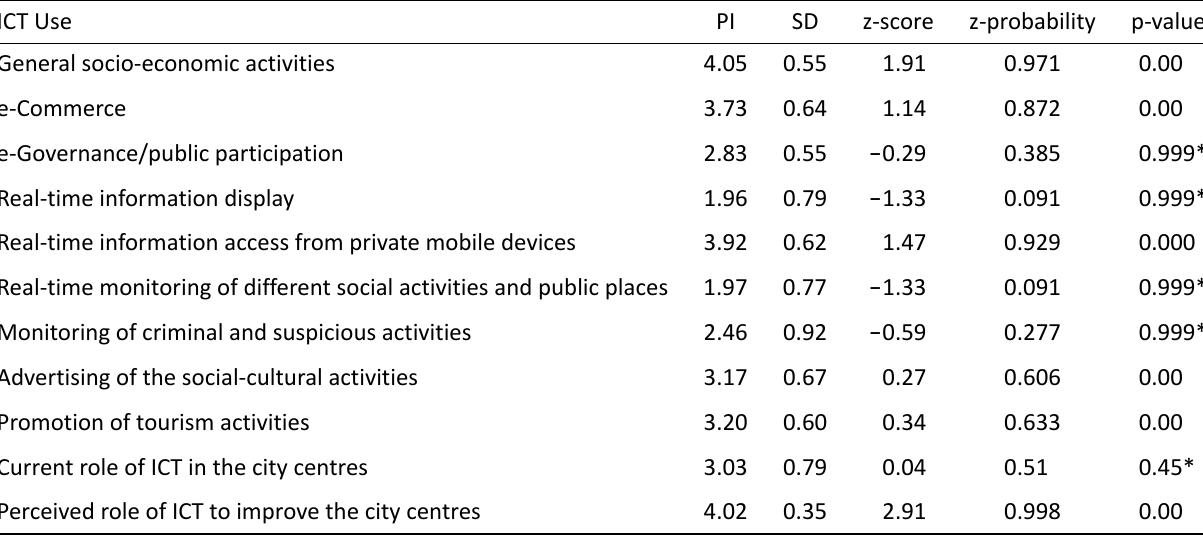
Table 3. Use of ICT in different activities in the city centres.